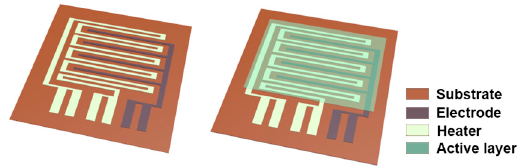
Figure 1. Device layout. Left: electrode and heater. Right: active layer over both elements. Device size 14 × 14 mm 2